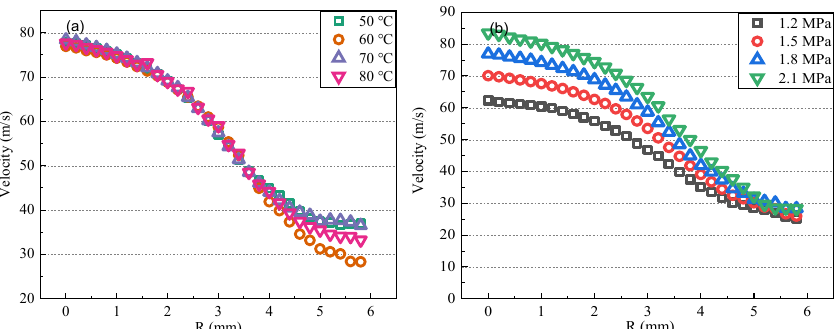
Figure 11. Effects of injection temperature and pressure on the variation of droplet velocity along spray radial direction. ( a ) Effect of T inj on velocity variation under P inj = 1.5 MPa; ( b ) Effect of P inj on velocity variation under T inj = 60 °C.